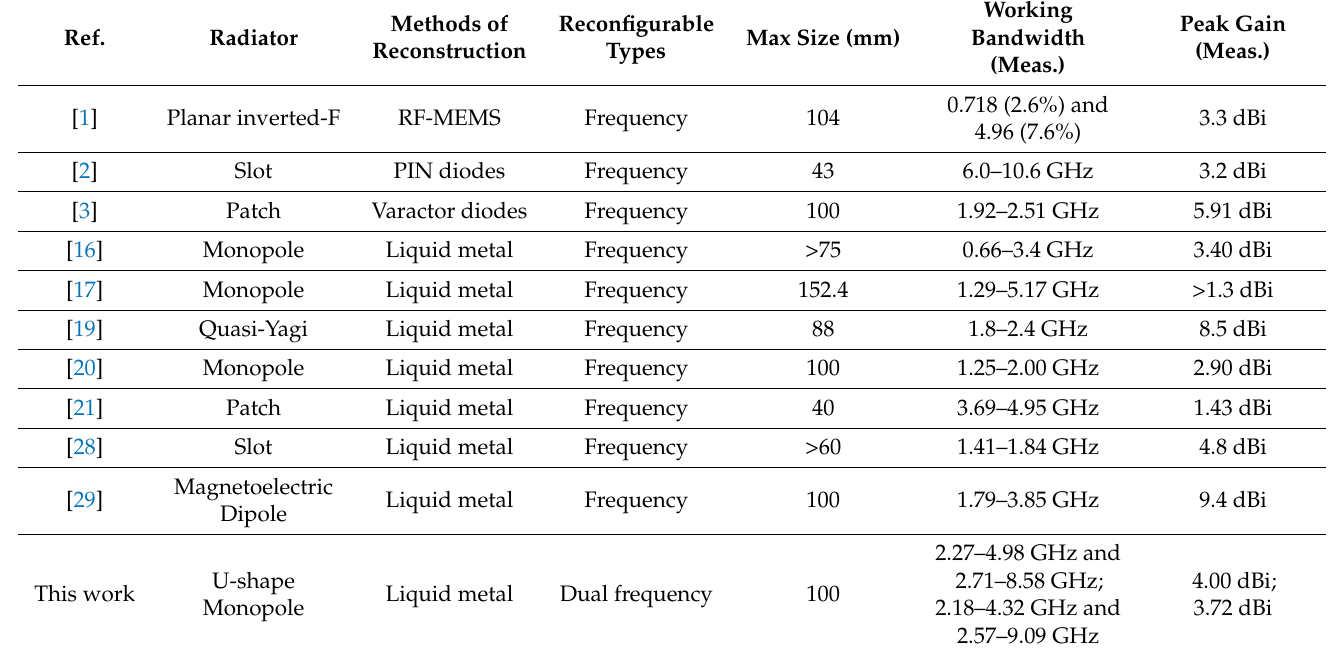
Table 4. Performance comparison for different antenna